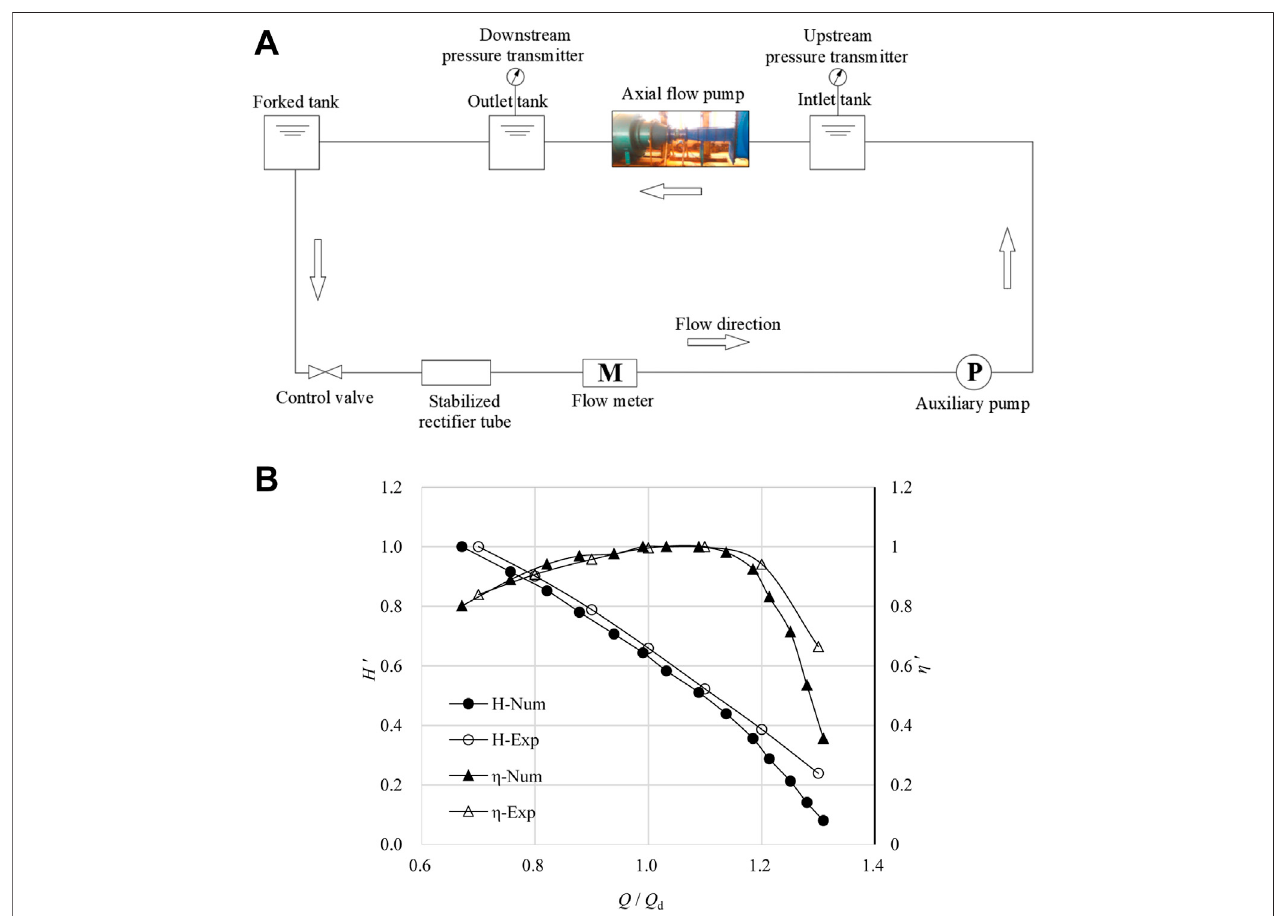
FIGURE 4 | (A) Schematic diagram of the test system. (B) Experimental and numerical simulation results.